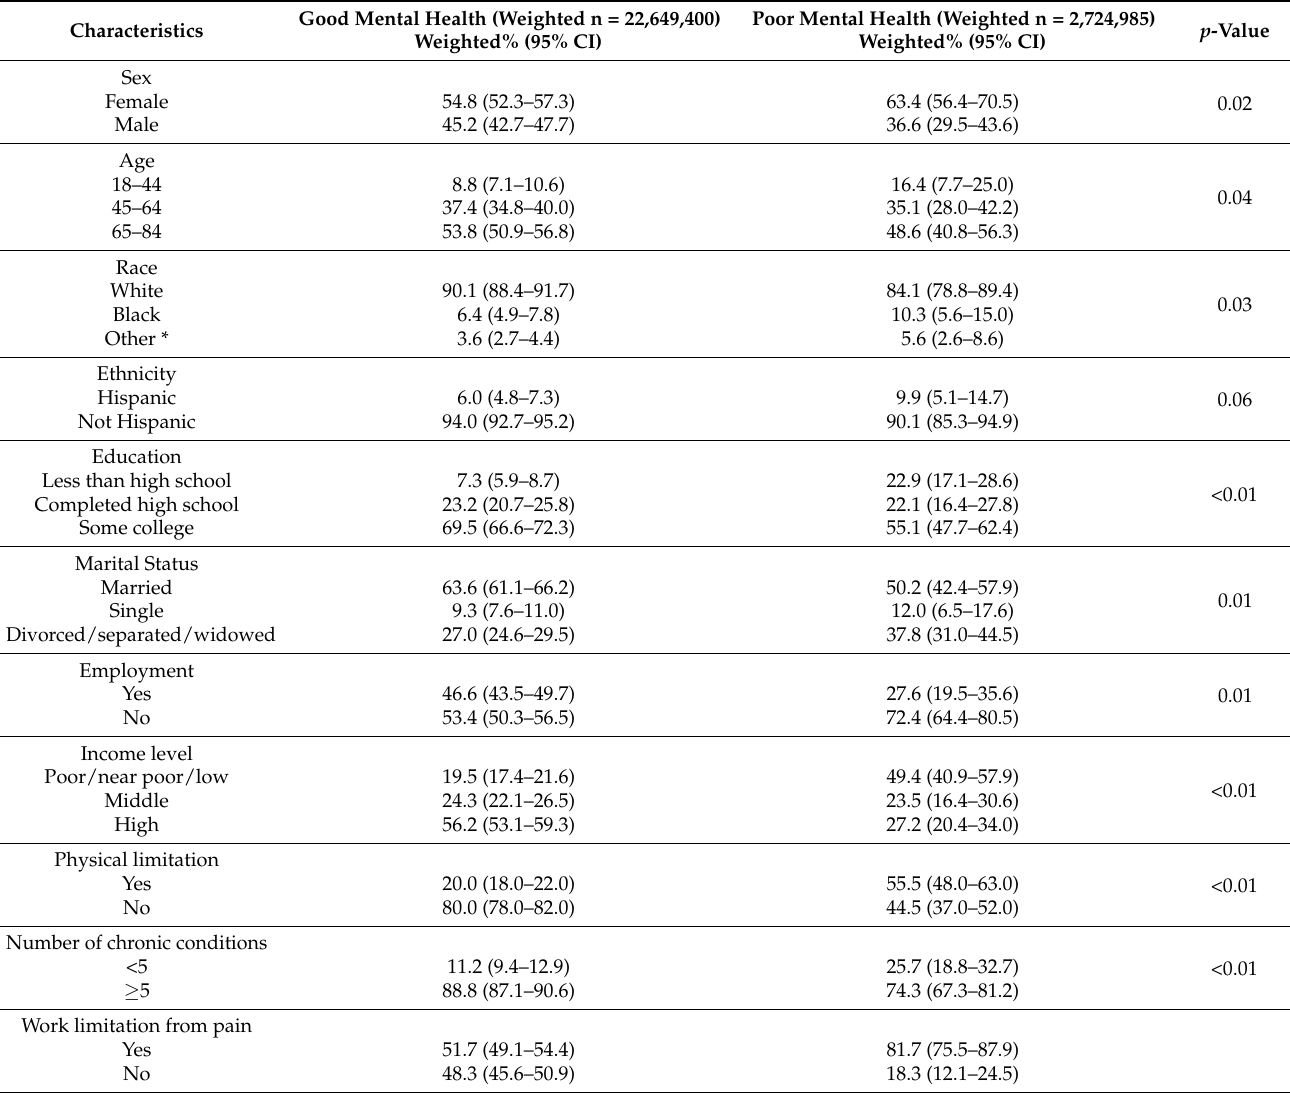
Table 1. Population characteristics of United States (U.S.) adults with a diagnosis of cancer stratified by self-perceived mental health